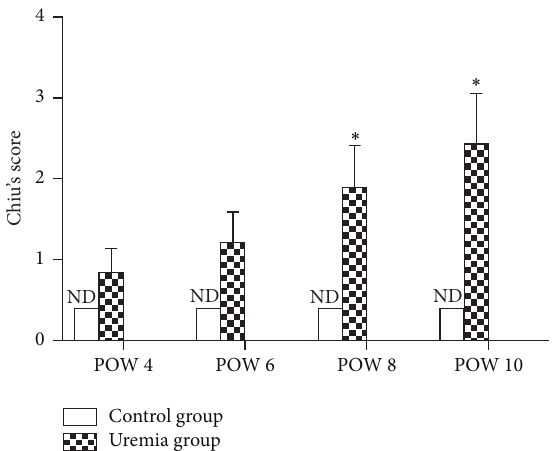
Figure 6: Chiu’s score in each group. ND: not detectable; POW: postoperative week. Data are expressed as the mean ± SD. ∗ 𝑃 < 0.05 , versus uremia group in POW